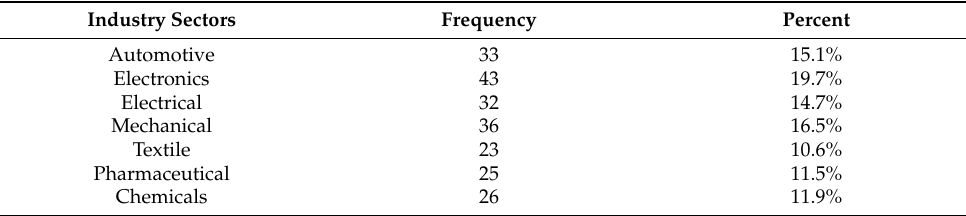
Table A1. Distribution of sample firms among industry sectors.